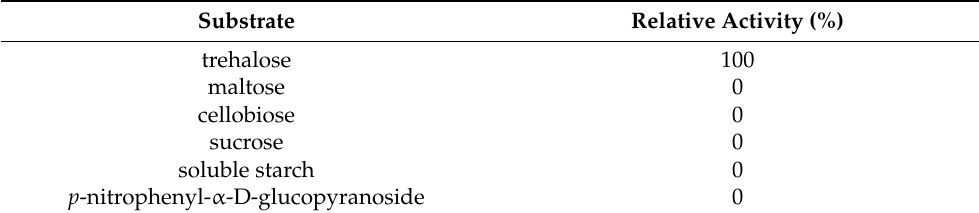
Table 1. Substrate specificity analysis of MpTre15A.